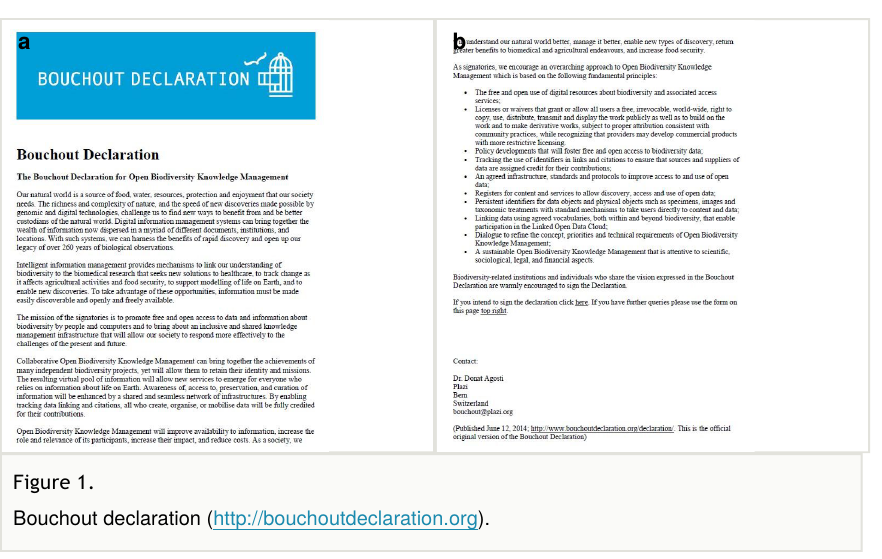
Bouchout declaration